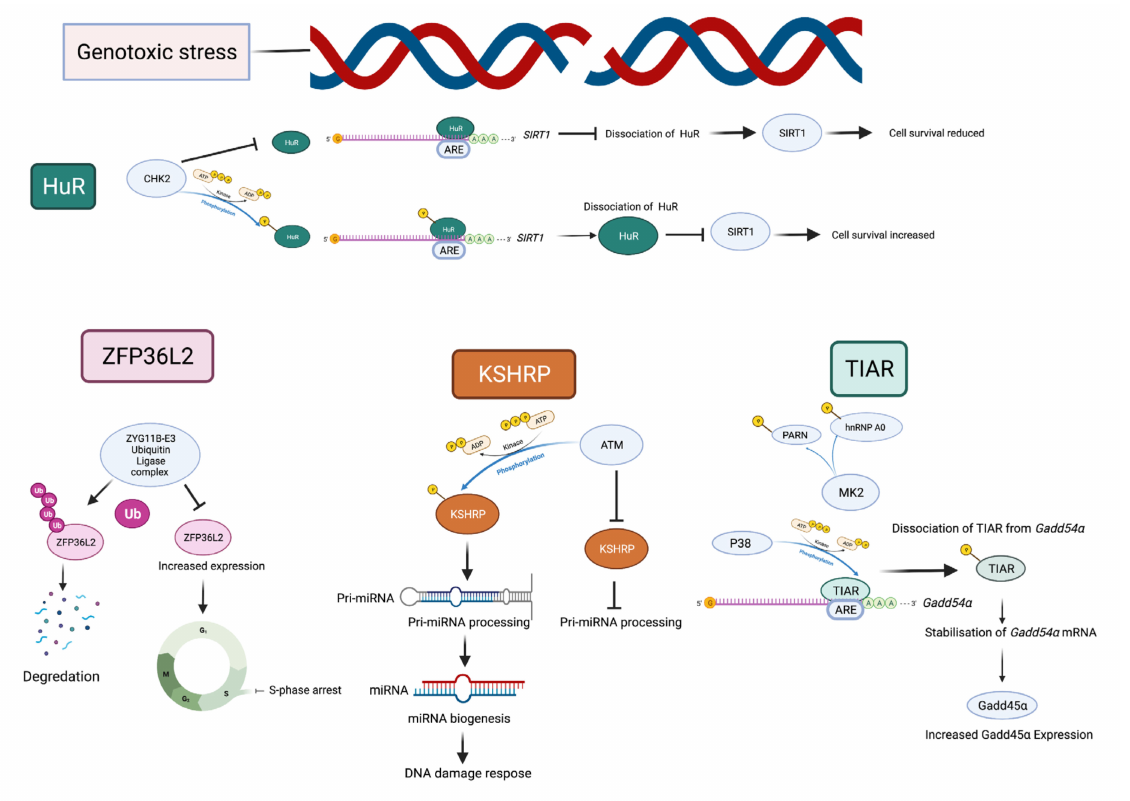
Figure 3. AU-RBPs exhibit post-translational modifications in response to genotoxic stress. Genotoxic stress results in post-translational modifications of AU-RPBs influencing their activity. The AU-RBP HuR is targeted for phosphorylation by CHK2 resulting in its dissociation from SIRT1 inhibiting SIRT1 expression and increasing cell survival. When CHK2 mediated phosphorylation of HuR is blocked, HuR remains bound to SIRT1 resulting in increased SIRT1 expression and decreasing cell survival. KSHRP is phosphorylated by ATM promoting its role in Pri-miRNA processing and miRNA biogenesis, which may have a role in the DDR. Concomitant phosphorylation of AU-RBP TIAR by p38 and PARN and hnRNP A0 by MK2 is involved in TIARs dissociation from Gadd45 α resulting in Gadd45 α ’s stabilization and increasing GADD45 α expression. Polyubiquitination of ZFP36L2 by ZYG11B-E3 ubiquitin ligase complex regulate ZFP36L2 expression levels ensuring its degradation. Genotoxic stress increases ZFP36L2 resulting in S-phase arrest which may be attributed to a reduction in polyubiquitination of